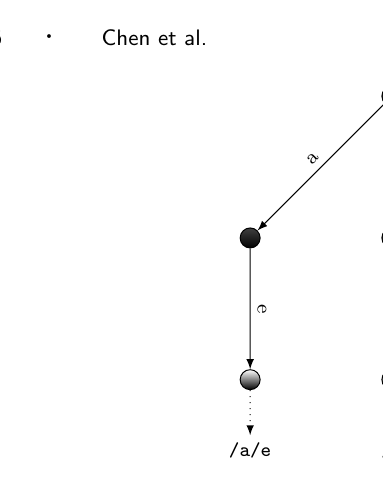
Fig. 4. Toy examples of partial path